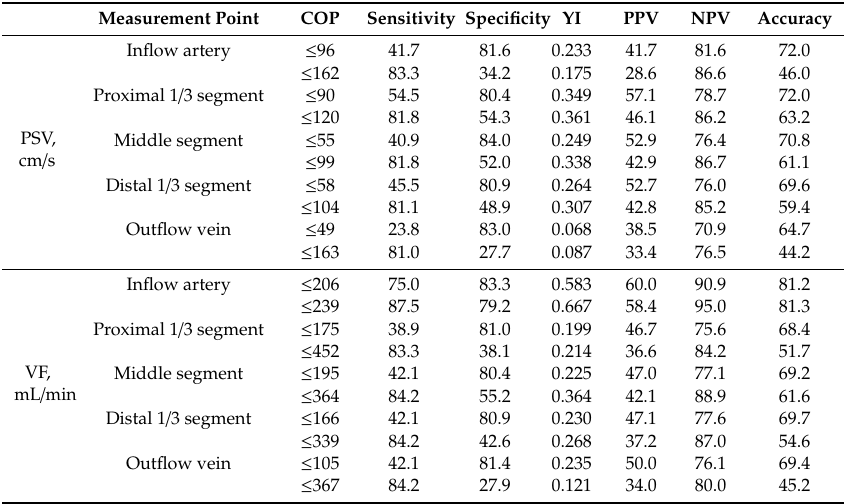
Table 4. Optimal cuto ff point (COP) for evaluating failed arteriovenous circuits by the peak systolic velocity (PSV) and volume flow (VF) values of various measuring